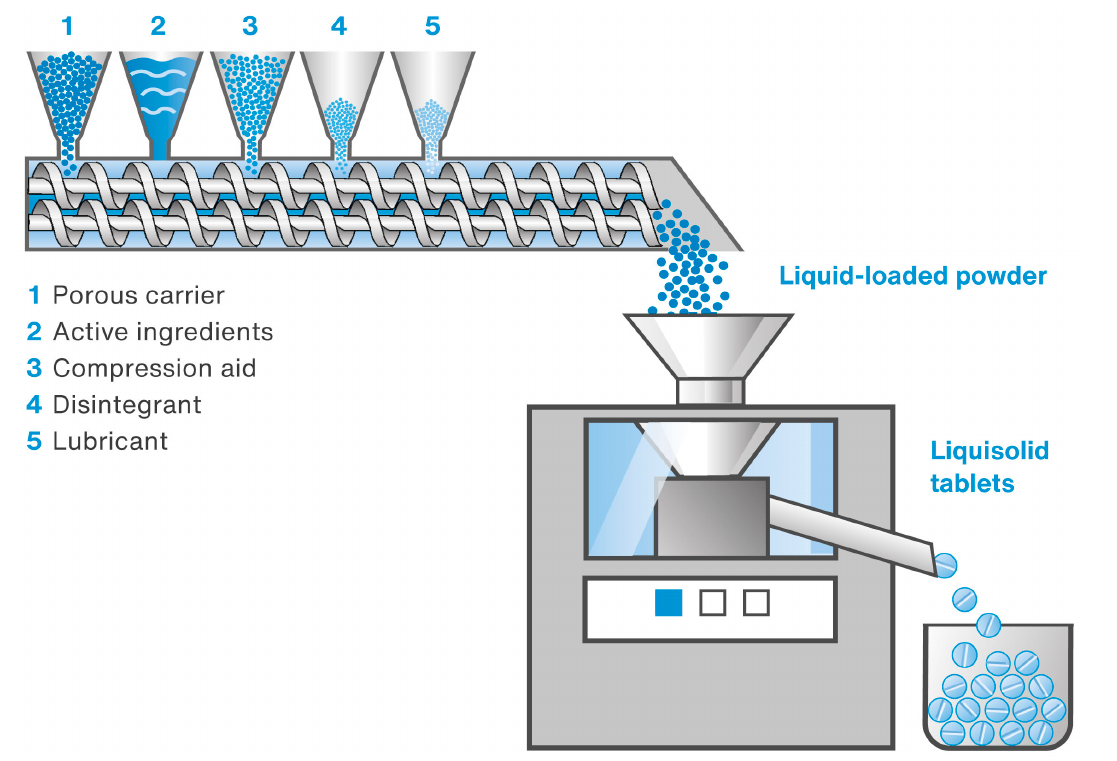
Figure 1. Schematic diagram of a production line for manufacturing liquisolid tablets containing simethicone and loperamide hydrochloride.